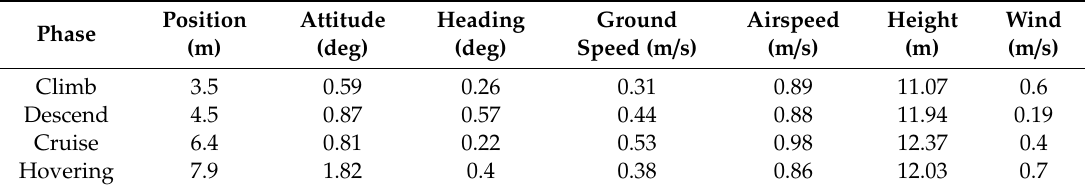
Table 7. The error precision of flight parameters in di ff erent phases.